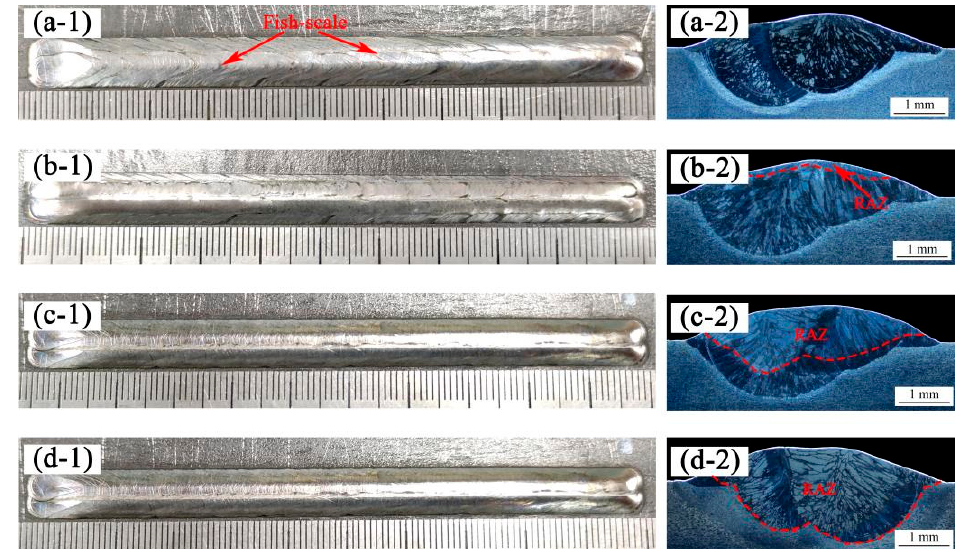
Figure 4. Macroscopic morphology of laser cladding coating: ( a-1 ) as-cladded DSS coating, ( b-1 ) as- remelted-1kW DSS coating, ( c-1 ) as-remelted-3kW DSS coating, ( d-1 ) as-remelted-5kW DSS coating. Cross-section of laser cladding coating: ( a-2 ) as-cladded DSS coating, ( b-2 ) as-remelted-1kW DSS coating, ( c-2 ) as-remelted-3kW DSS coating, ( d-2 ) as-remelted-5kW DSS